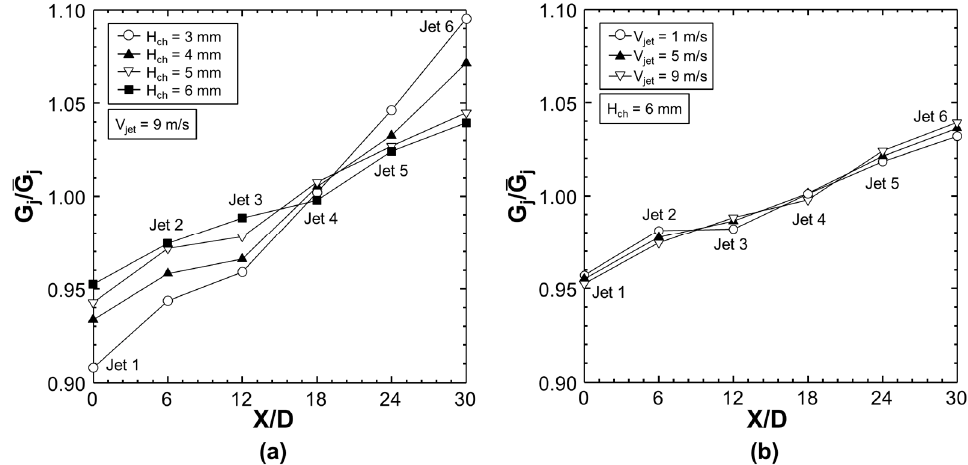
Figure 7. Variation of jet exit mass velocity at each jet holes: ( a ) V jet = 9 m/s at H ch = 3, 4, 5, and 6 mm; ( b ) H ch = 6 mm at V jet = 1, 5, and 9 m/s. 6 mm; ( b ) H ch = 6 mm at V jet = 1, 5, and 9